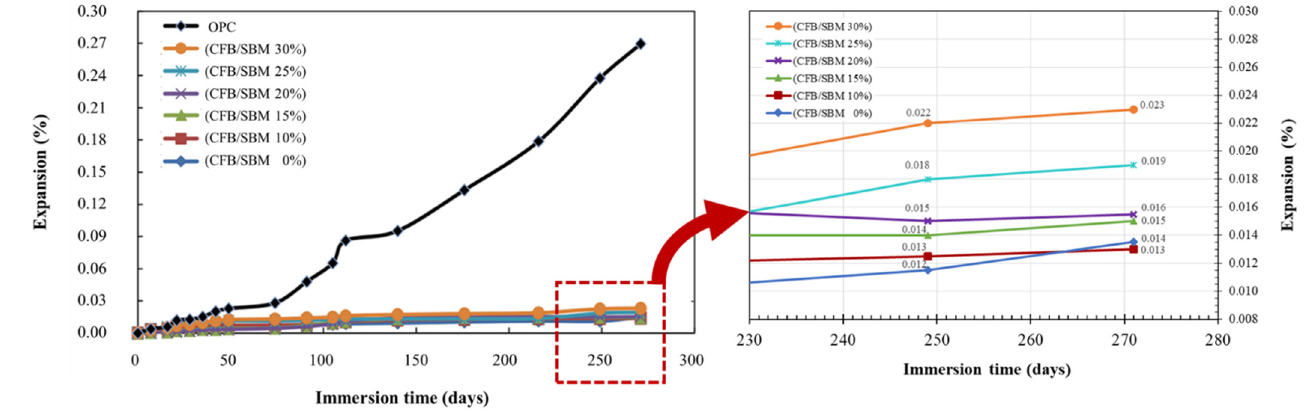
Figure 6. Expansion of mixture mortars with different CFB fly ash/SBM ratios under external sulfate attack.